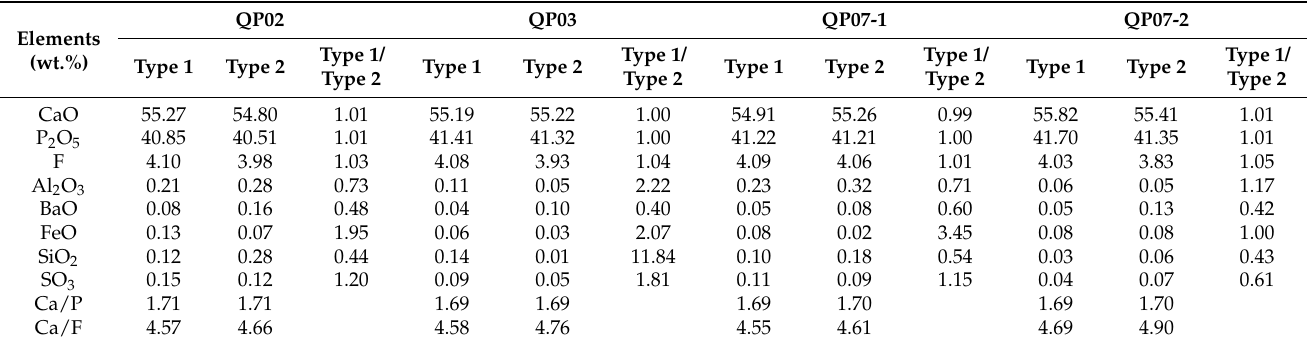
Figure 4. Representative points and grouping. Notes: on the left is the microscope photo and on the right is the BSE picture; The red points are typical points of Type1, yellow points are typical points of Type2. Table 3. Contents of major elements in different regions of apatite.